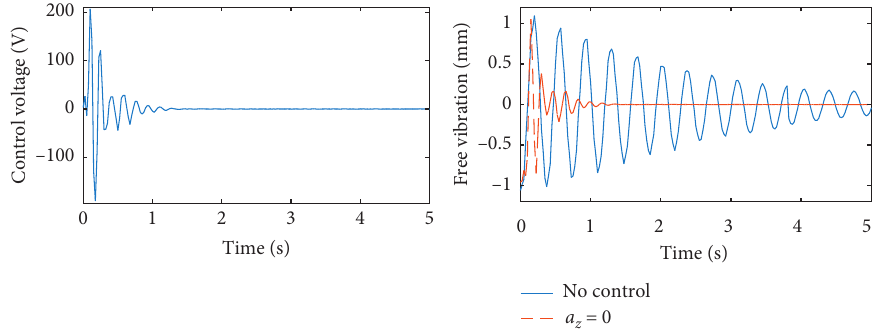
Figure 11: Control result at a